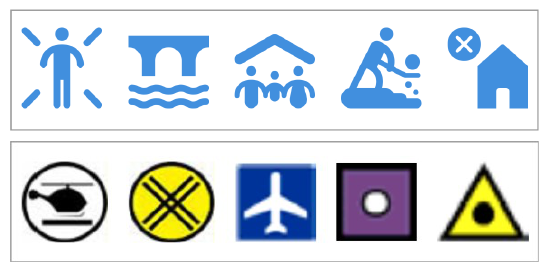
Figure 5. Thematic organisation has not been transferred into the visual appearance of the symbols in OCHA's Humanitarian Icons (top) and Humanitarian Demining Map Symbols (bottom). The associative and selective properties of cartographic symbols were not